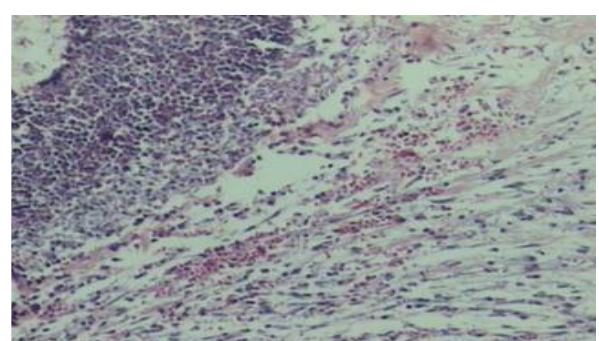
FIGURA 3 – Fotomicrografia de inflamação aguda. Legenda: 3º dia pós-operatório SGC (coloração H.E., aumento 100x). Nota: 1= infiltrado de neutrófilos. 2 = área de edema